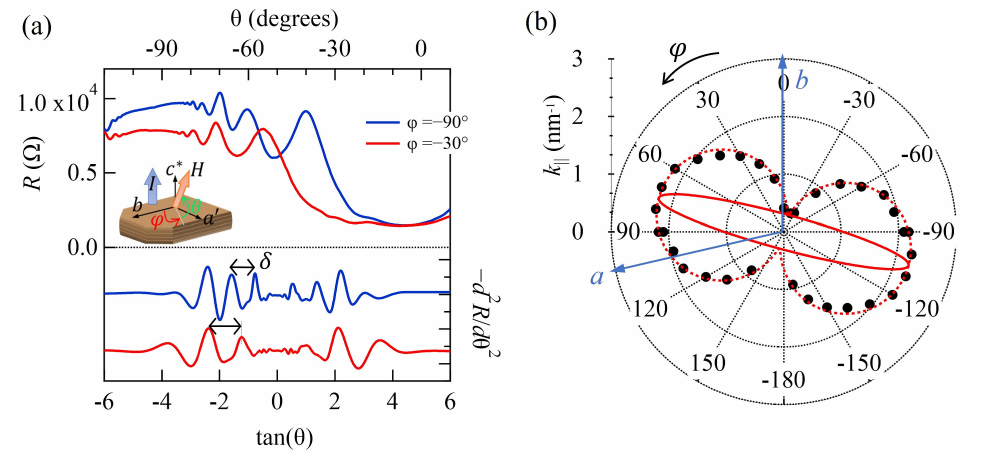
Figure 2. ( a ) Typical AMRO data and their negative second derivative curves at 1.5 K for 14 T. ( b ) Polar plot of k (cid:107) obtained from the AMRO measurements. The red solid curve shows the 2D Fermi surface obtained from the AMRO measurements.